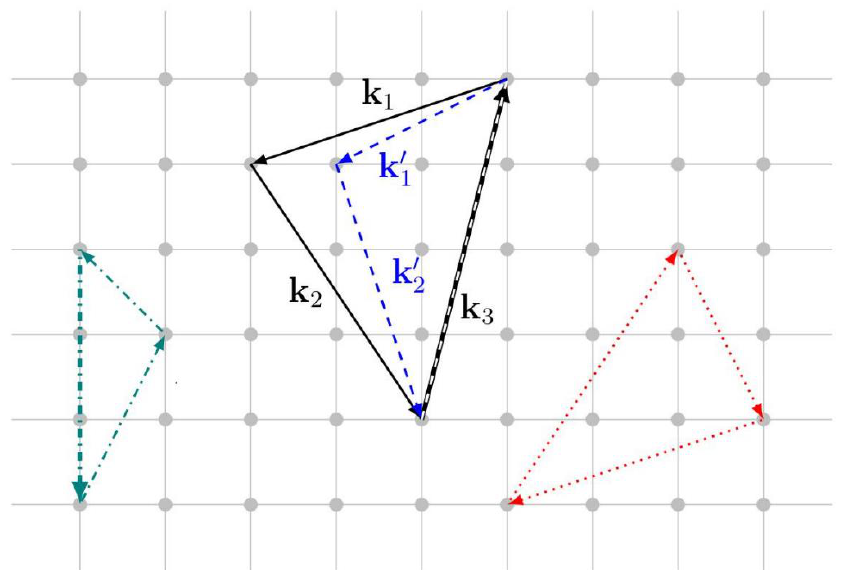
Figure 1. Color online. Triads on an integer lattice. Each mode has an integer length in both directions, 𝐤 = (𝑘 𝑥 , 𝑘 𝑦 ) = (𝑚, 𝑛) . Each triad satisfies 𝐤 1 + 𝐤 2 = 𝐤 3 and therefore forms a triangle (the location of the triangle on this grid has no significance). The triads shown represent a resonant triad (black, solid) and a quasi-resonant triad (blue, dashed) in its one-vicinity (also called a near-resonance); a general detuned triad (red, dashed); and a zonal triad (teal, dot-dashed), which is a (detuned) triad that includes a zonal mode (has 𝑘 𝑥 = 𝑚 = 0 and is therefore vertical).